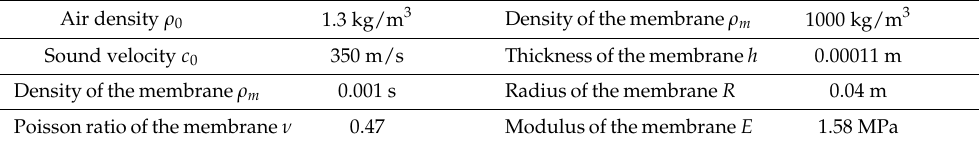
Table 1. The parameters of the system.